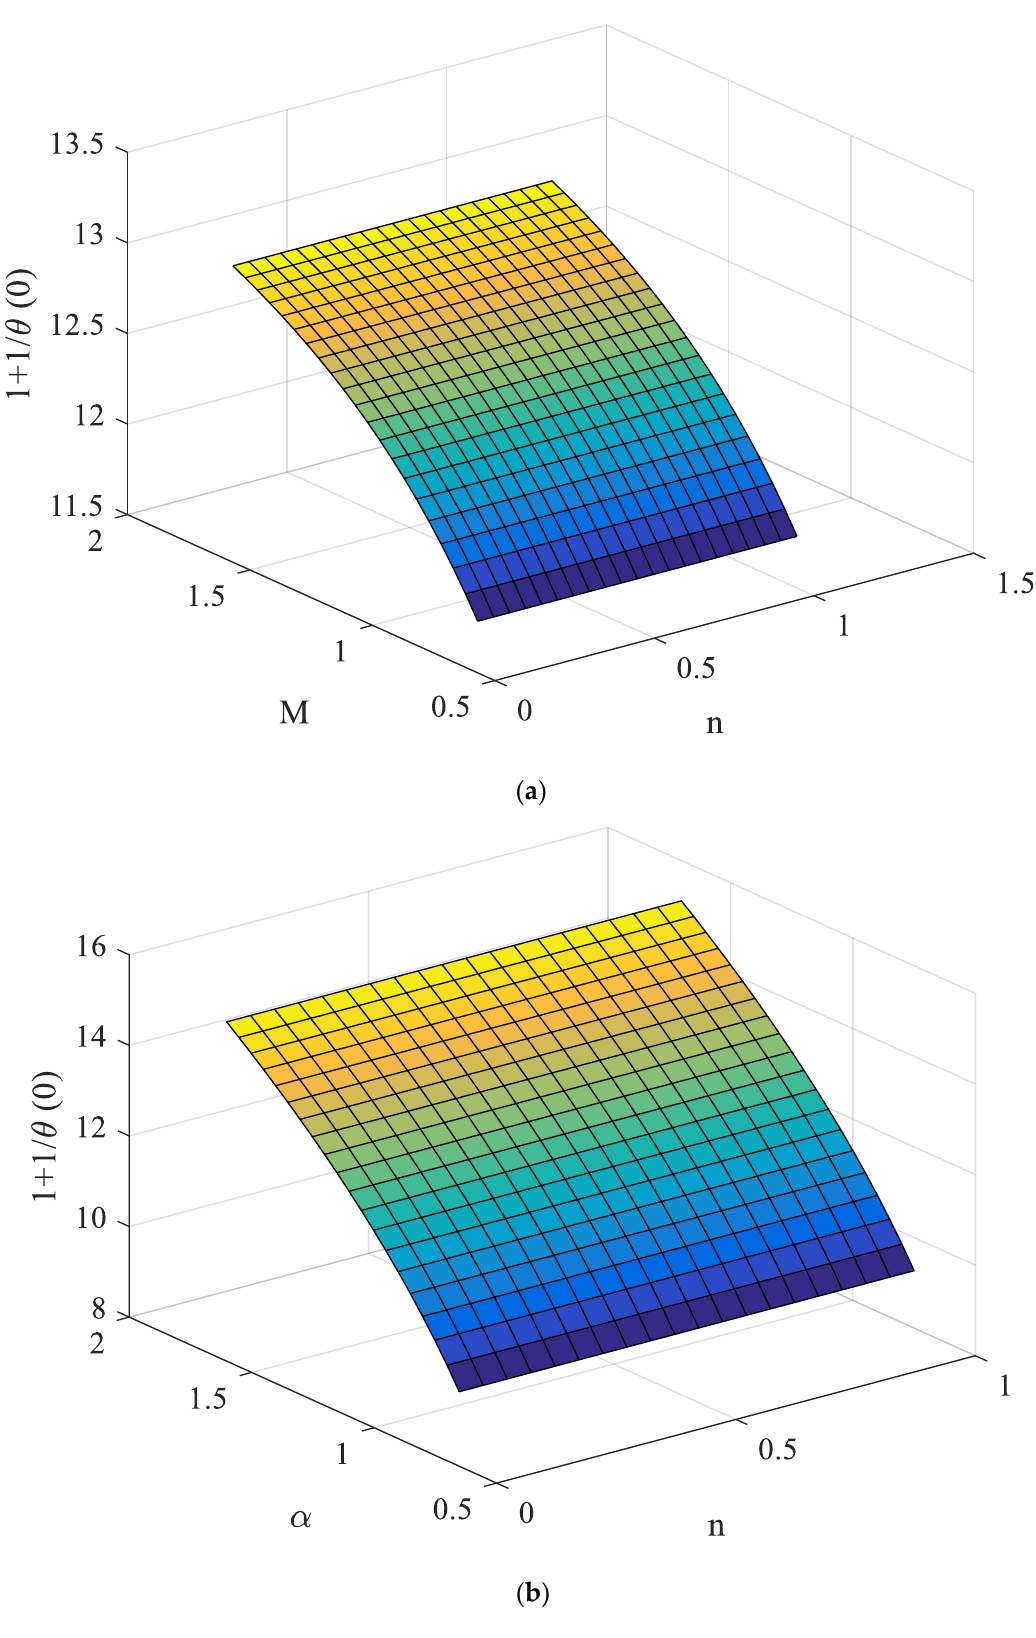
Figure 11. ( a ): Three-dimensional plot for Nusselt number in NH case for different values of M & n . ( b ): Three-dimensional plot for Nusselt number in NH case for different values of α & n .